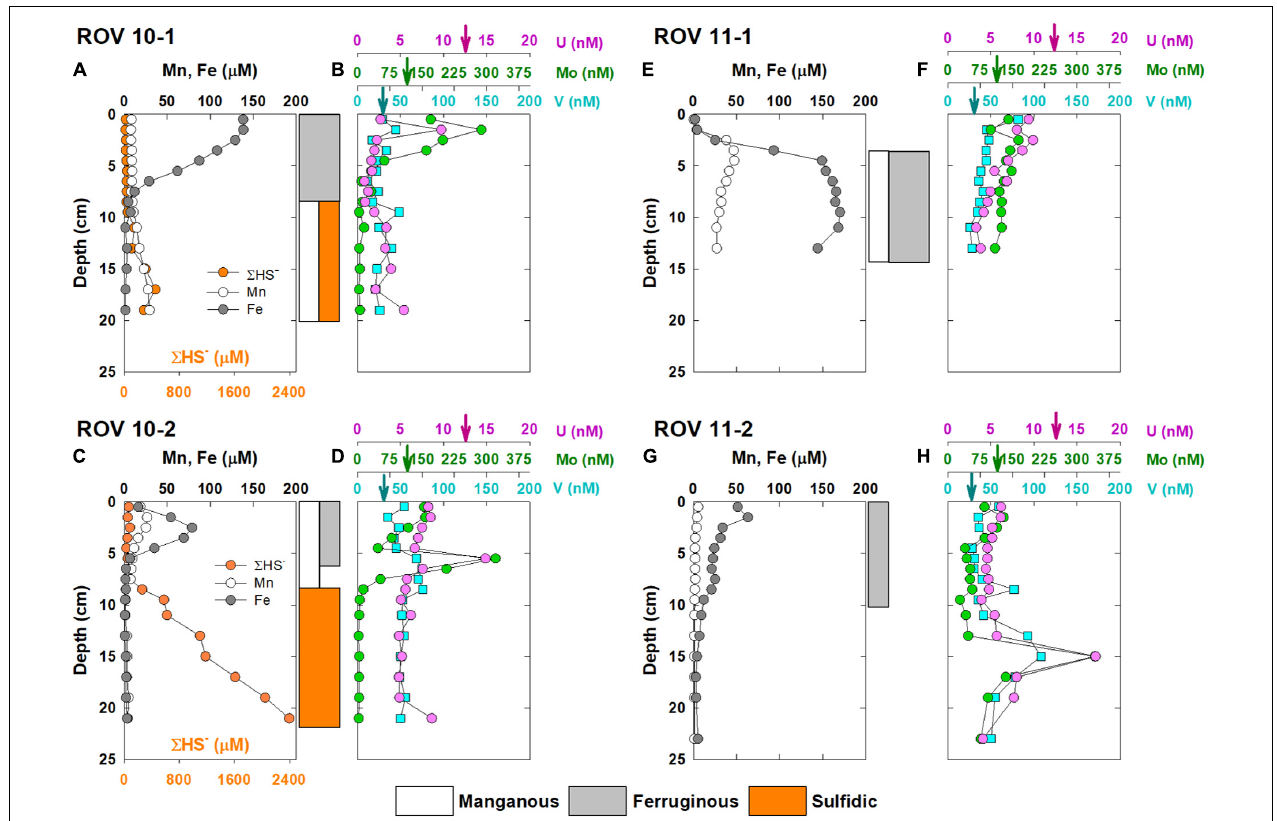
FIGURE 2 | Vertical concentration profiles of dissolved Fe, Mn, (cid:54) HS - , Mo, U and V in core ROV 10-1 (A,B) , ROV 10-2 (C,D) , ROV 11-1 (E,F) , and ROV 11-2 (G,H) , collected from the southern Okinawa Trough. The arrows indicate concentrations of RSEs (Mo, U, V) in the overlying water column. The color-coded blocks on the right of the figures demark the dominant diagenetic reactions (e.g., manganous, ferruginous, and sulfidic) in corresponding layers of